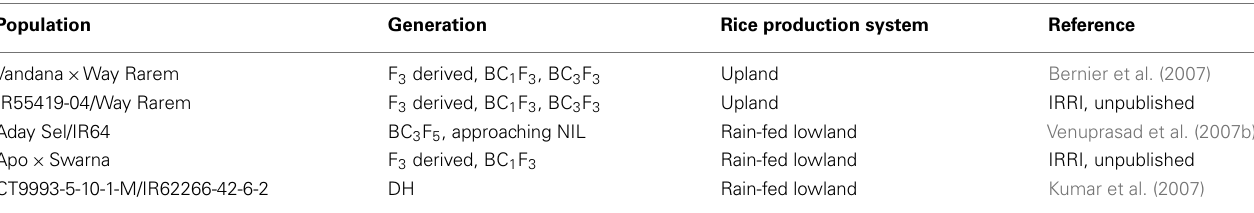
Table 3 | Rice breeding populations for detecting large-effect QTLs for yield under drought stress under upland and rain-fed lowland production systems; genetic stocks maintained at IRRI (Source: information provided byArvind Kumar,